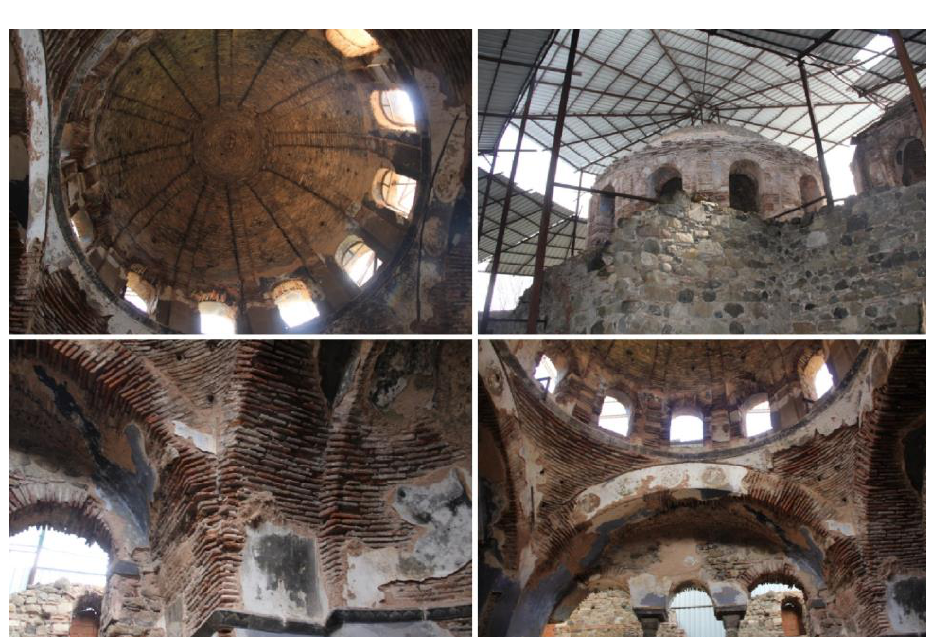
Figure 5. Views of domes, arches and pendentives at naos.